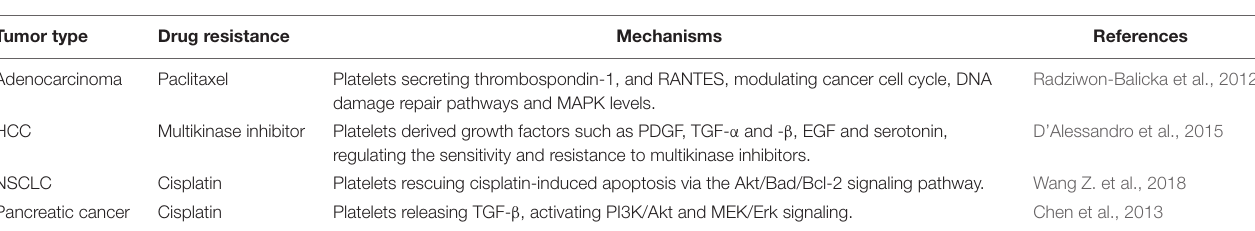
TABLE 8 | Mechanisms of antitumor drug resistance mediated by